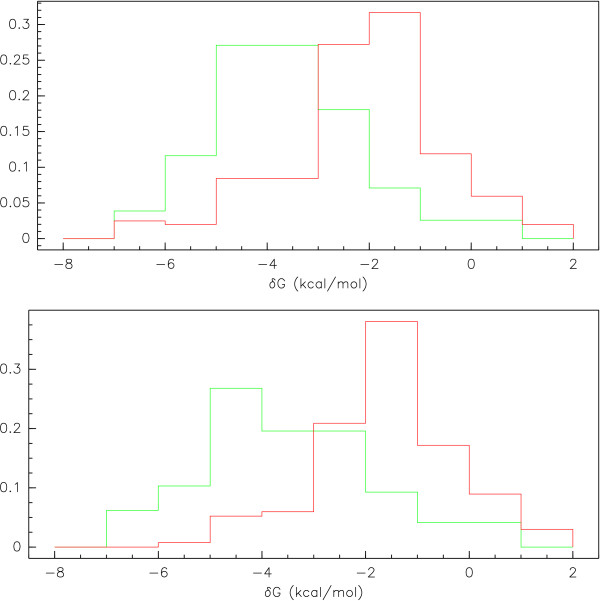
Thermodynamic Distributions of (top) Significant Motifs and (bottom) Submotif-unique Significant Motifs. The distributions of Gibbs free energy values (dG) for sequences associated with effective antisense activity (green) and those associate with ineffective antisense activity (red). The difference in average dG between "good" and "bad" motifs in the subword-unique motifs (-3.45 vs. -1.66 kcal/mol) is greater than the difference in means in the entire population of significant motifs (-3.59 vs. -2.105 kcal/mol). This can be attributed to the removal of motifs from each population that contain submotifs in the opposing group.